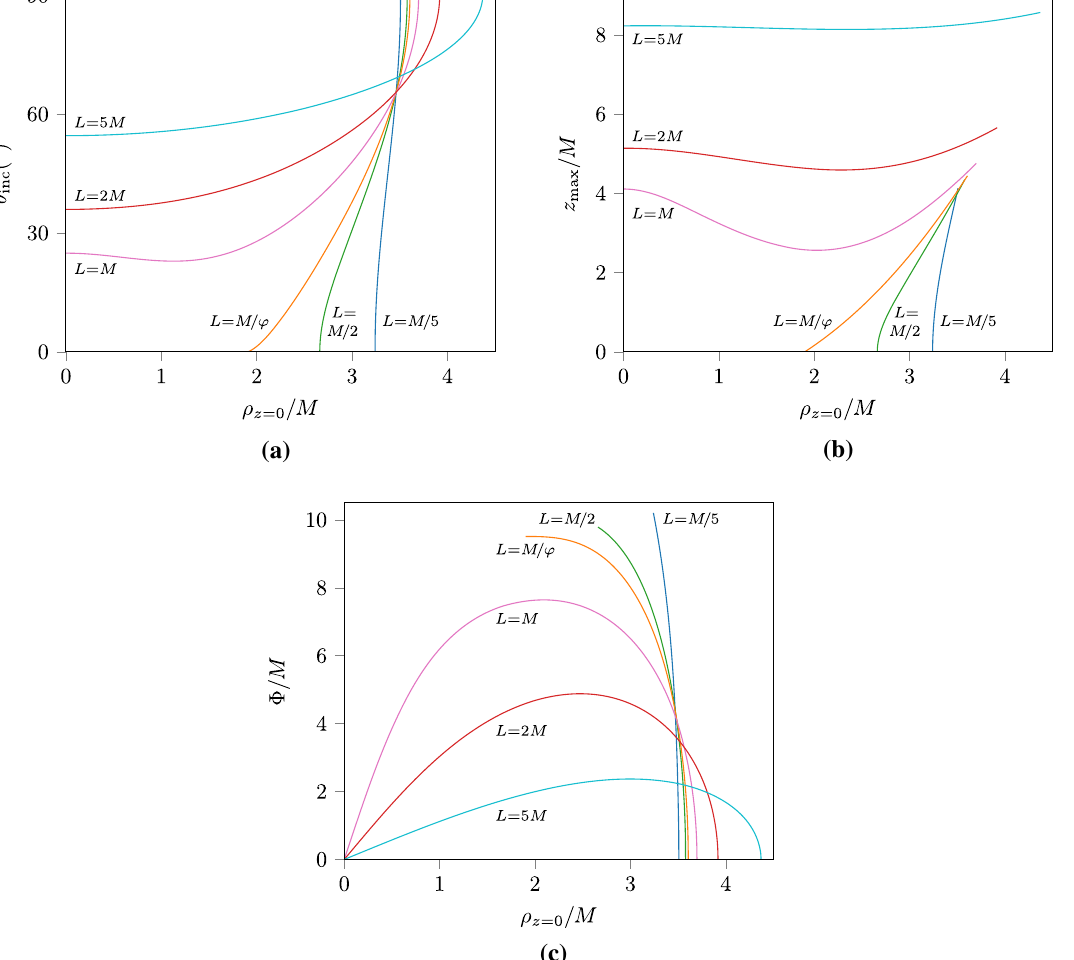
Fig. 7 Plots of a θ inc against ρ z = 0 , b z max against ρ z = 0 , and c (cid:9) against ρ z = 0 , for the Class A FPOs, for various values of L as